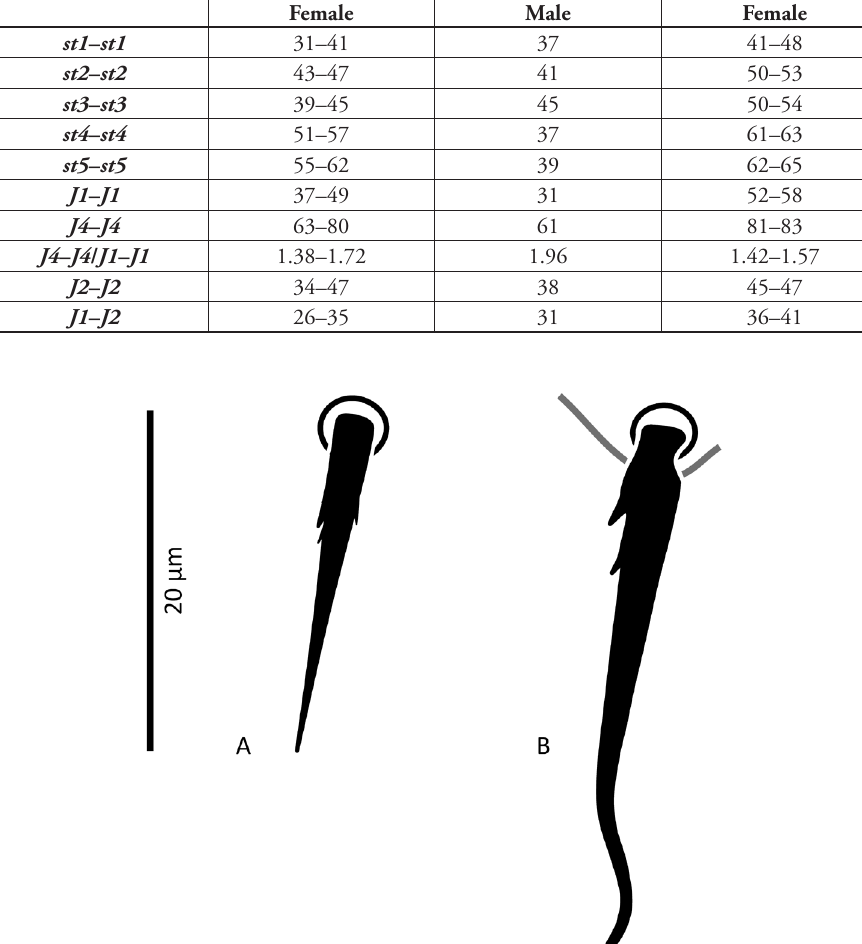
portion rounded, indistinct; shield closely abutting ventrianal shield; three pairs of suboval to subcircular sigillae medially, posterior ones larger, oval. Setae st5 smooth, inserted near shield lateral margins. Poroids iv5 near posterolateral margins of epigy- nal shield. Ventrianal shield subpentagonal, broad, 153–154 long, 189–196 wide (length/width ratio: 0.79–0.81), with straight anterior margin; distinctly lineate in anterior half, reticulate laterally and posteriorly; cells micropunctate inside and along cell margins; shield bearing five pairs of pre-anal and three circum-anal setae,